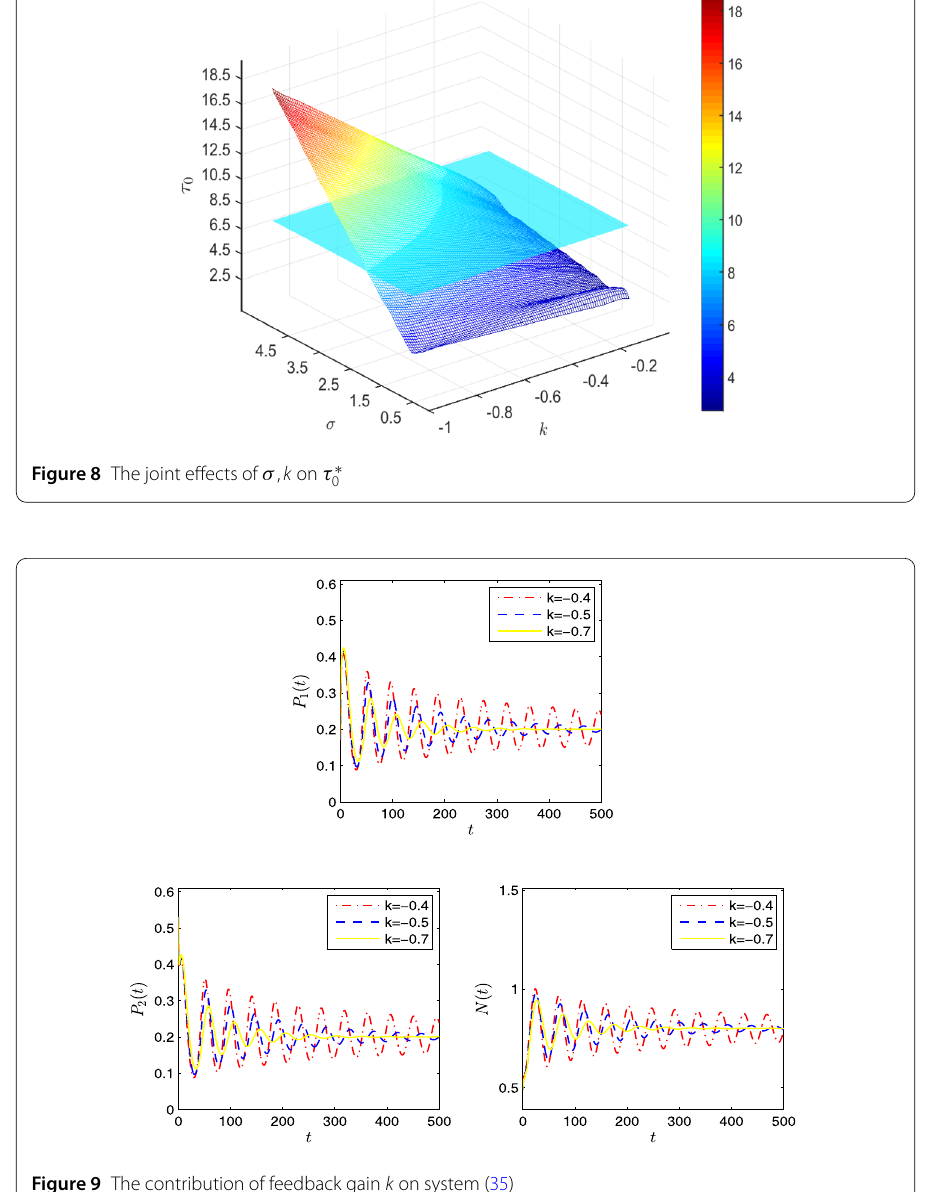
Figure 9 The contribution of feedback gain k on system